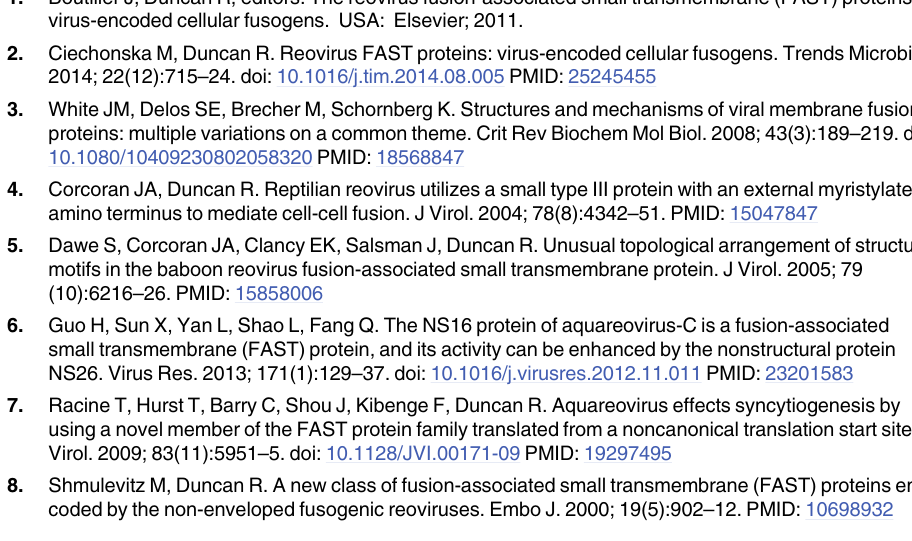
S3 Fig. Controls for quantitative recovery of liposomes from the top layer of sucrose gradi- ents independent of liposome size, and linear detection range of p15HPpep by HPLC. (A) Liposomes were labeled with 1% 1,2-dioleoyl-sn-glycero-3-phosphoethanolamine-N-(7-nitro- 2-1,3-benzoxidiazol-4yl) (NBD) and extruded to varying diameters (400 nm, 100 nm, or 50 nm). Liposomes were loaded on the bottom of a centrifuge tube, adjusted to 30% (w/v) sucrose and overlaid with 25% (w/v) sucrose and a top buffer layer. Gradients were centrifuged at 240,000 x g for 1h to float liposomes. The layers of the gradient were harvested and solubilized with 1.5% SDS and NBD fluorescence was determined. All fluorescent readings fell within a linear detection range indicating equivalent quantitative recovery of different sized liposomes / F ). F was determined by reading from the sucrose gradient. % Fluorescence = (F Top Input Input fluorescence of liposomes prior to loading on gradient. (B) Linear detection range of wt p15HPpep by HPLC. Eluted peptide was detected at 215 nm and the corresponding area under the peak was quantified using Waters